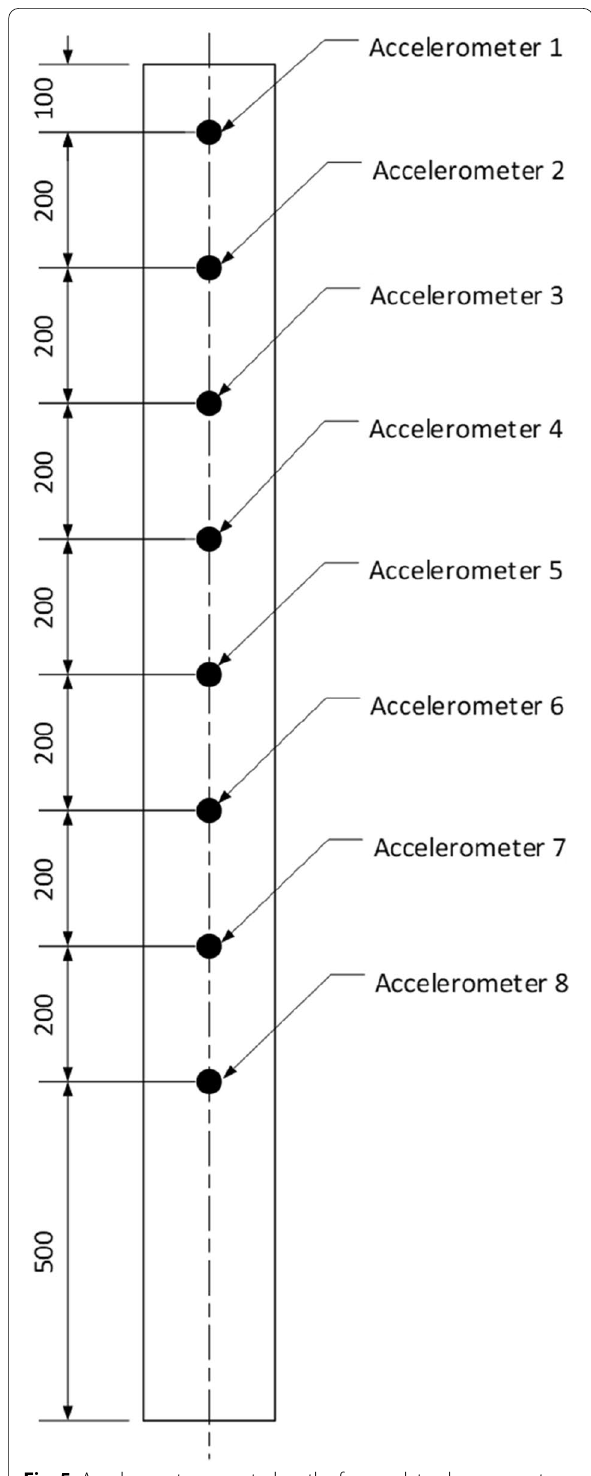
Fig. 5 Accelerometer mounted on the frame – lateral